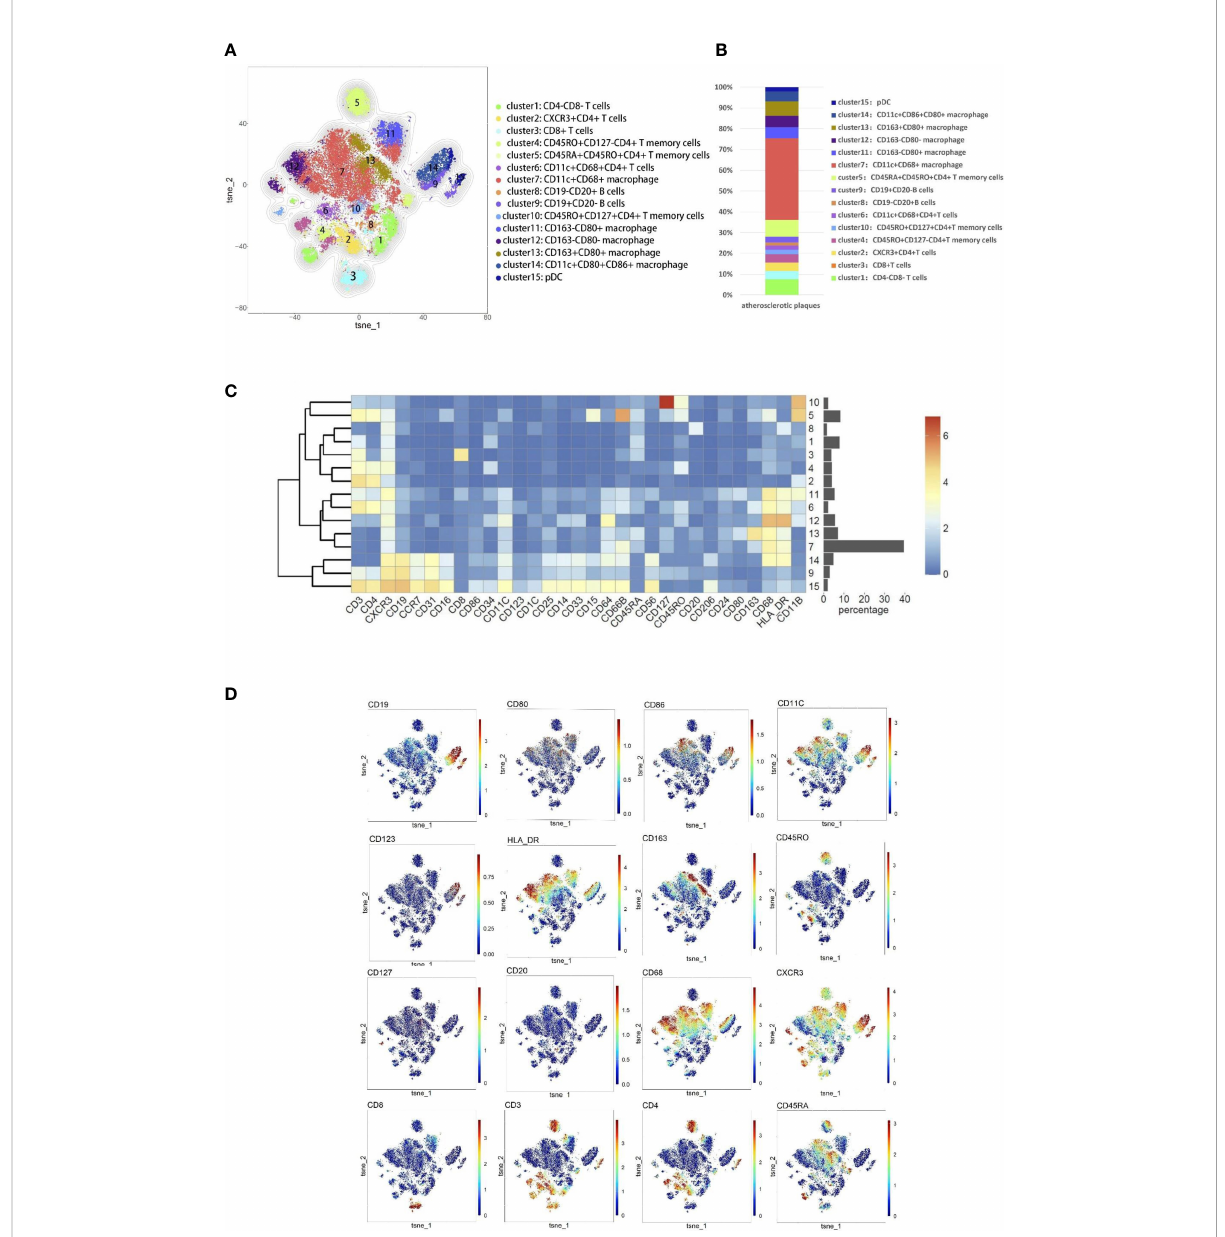
FIGURE 3 Cellular components within atherosclerotic plaques. (A) The analysis identi fi ed 15 populations, including T lymphocyte cells and macrophages. High-dimensional characterization of the mononuclear cell was shown by t-SNE. (B) The accumulation histogram presented the proportion of cell subsets within the plaques. (C) Heatmap showing the relative expression level of the chosen markers within the 15 cell subsets identi fi ed by the t-SNE clustering shown in (A) . (D) Markers of the particular cell were displayed by spectral colors on t-SNE